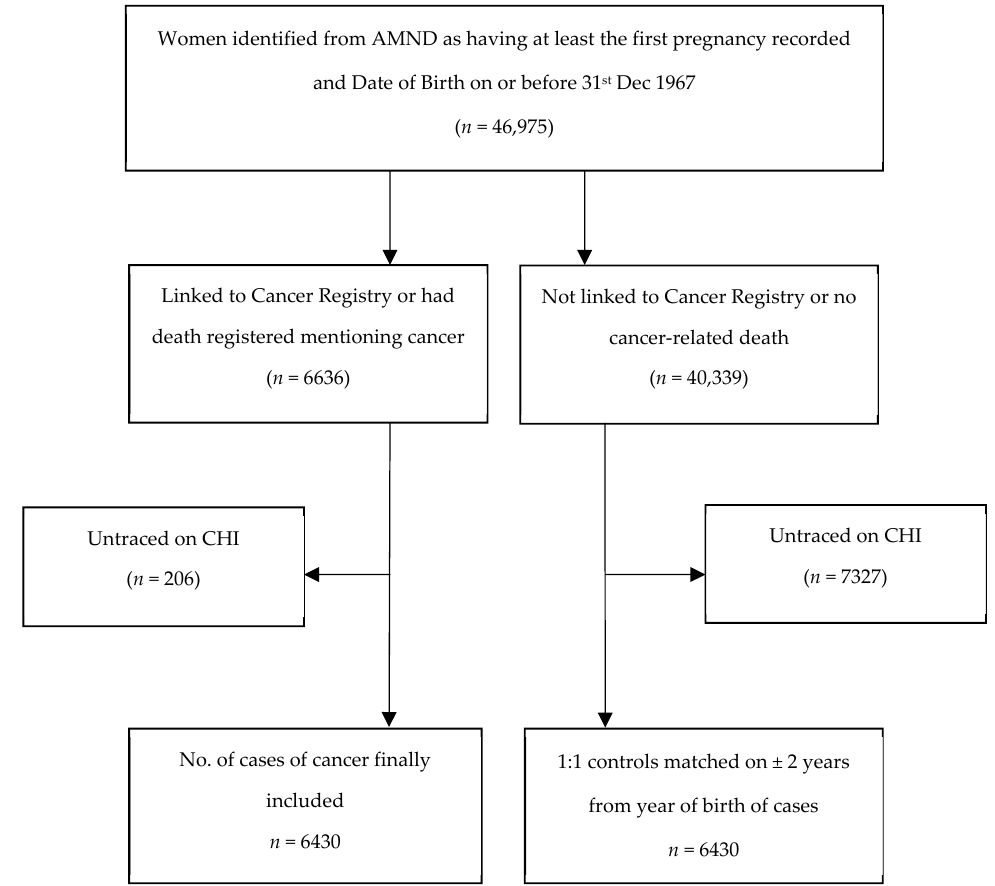
Figure 1. Flow chart of selection of cases (women with cancer) and controls (women without cancer).